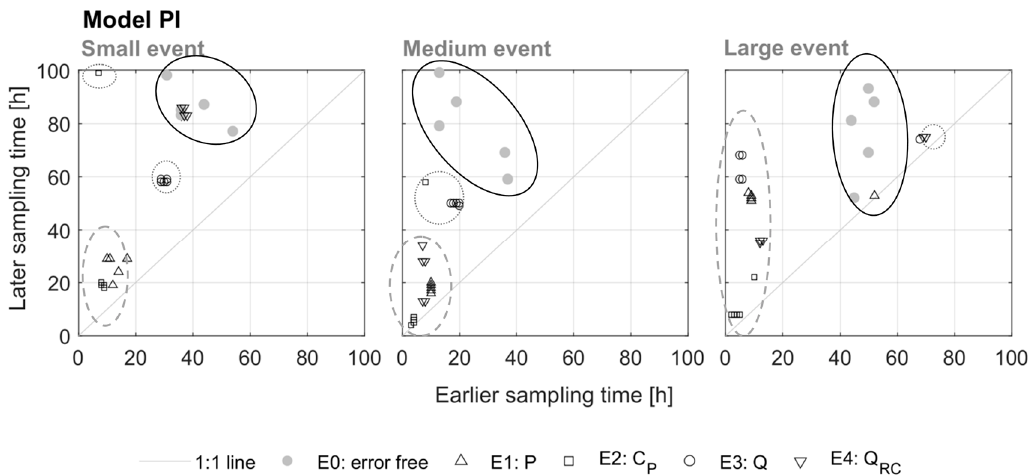
Figure 8. Timing of the most informative sampling pairs for model parameterization PI. Grey dots show the most informative sampling pairs for the error free case ( I 0_2 ), the other four symbols show the most informative sampling pairs for the four different error types ( I e_2 ). The solid circle encompasses the most informative sampling pairs where there are no errors ( I 0_2 ), the dotted circle includes the groups of most informative sampling pairs that differed only slightly in timing compared to the error free case, and the dashed circle indicates groups of the most informative sampling pairs that differed most in timing compared to the error free case. Table 4. Difference in the timing of the most informative sampling pairs when there are data errors ( I e_2 ) and when there are no data errors ( I 0_2 ). Parameterization